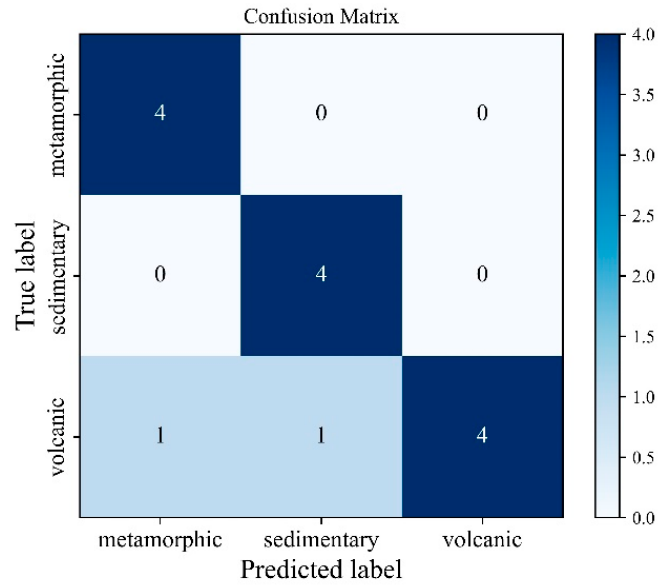
Figure 28. Confusion matrix of the final classification results.